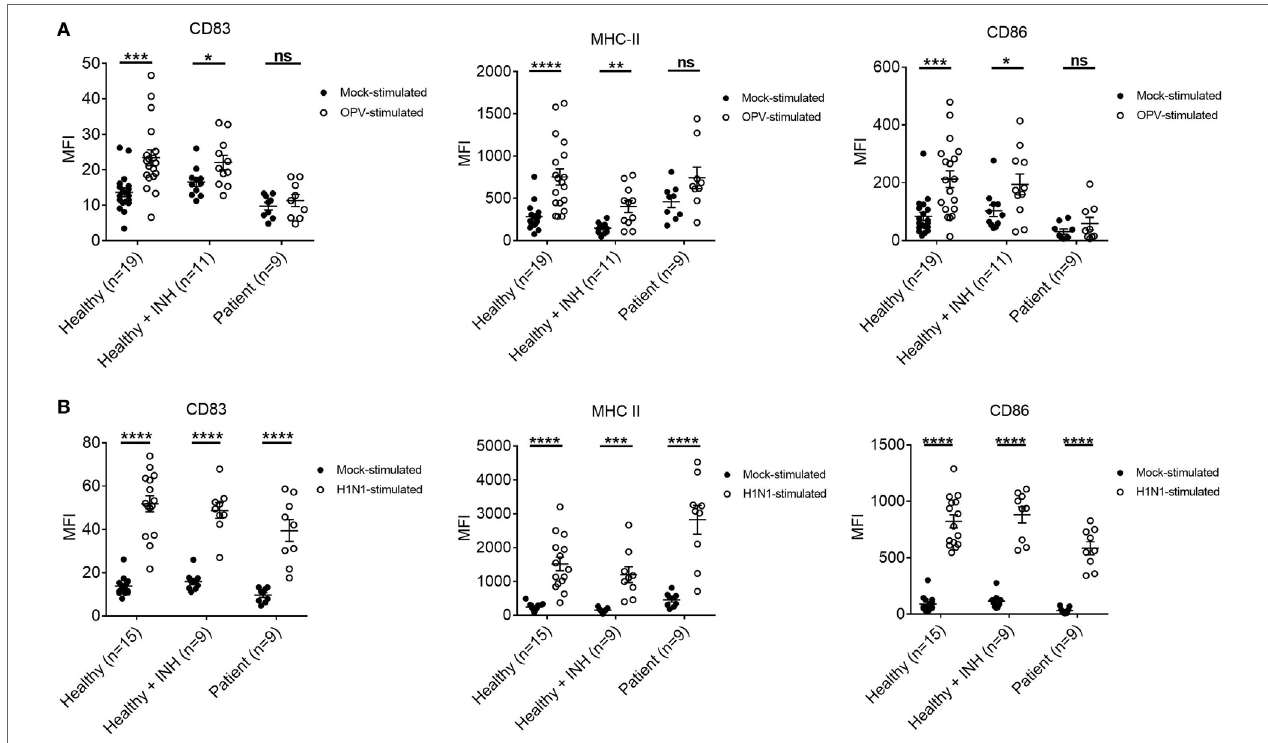
FigUre 6 | Surface marker changes in MoDCs from healthy controls, Bruton’s tyrosine kinase (BTK)-inhibited MoDCs from healthy controls, and MoDCs from X-linked agammaglobulinemia (XLA) patients upon OPV and H1N1 stimulation. MoDCs were stimulated with OPV and H1N1 at multiplicity of infection of 1 for 24 h. Open symbols represent MoDCs stimulated with OPV or H1N1; filled symbols represent MoDCs that were mock-stimulated with RPMI. Healthy + INH, BTK- inhibited MoDCs from healthy controls. Data represented as mean ± SEM. ns, p > 0.05; * p < 0.05; ** p < 0.01; *** p < 0.001; and **** p < 0.0001. (a) MFI of CD83, MHC-II, and CD86 in MoDCs from healthy controls ( n = 19), BTK-inhibited MoDCs from healthy controls ( n = 11), and MoDCs from XLA patients ( n = 9) upon OPV stimulation. (B) MFI of CD83, MHC-II, and CD86 in MoDCs from healthy controls ( n = 15), BTK-inhibited MoDCs from healthy controls ( n = 9), and MoDCs from XLA patients ( n = 9) upon H1N1 stimulation. Controls of MoDCs from healthy controls, BTK-inhibited MoDCs from healthy controls, and MoDCs from XLA patients were subsets of controls in Figure 6a